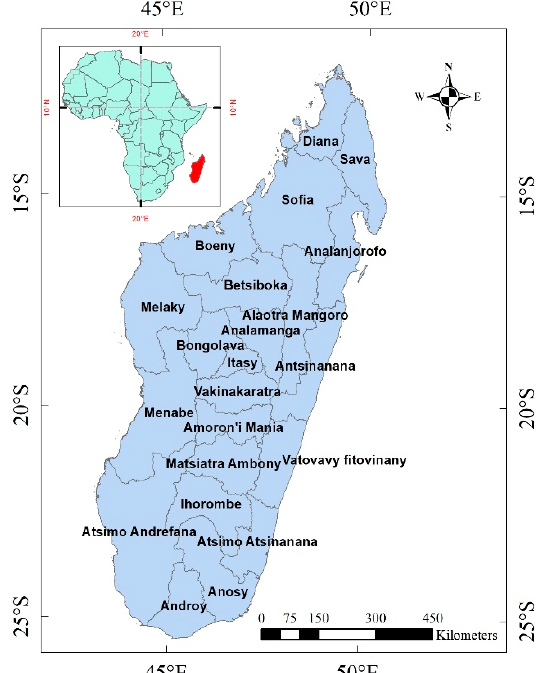
Figure A1. Localization of the study area with the name of regions used in this study.